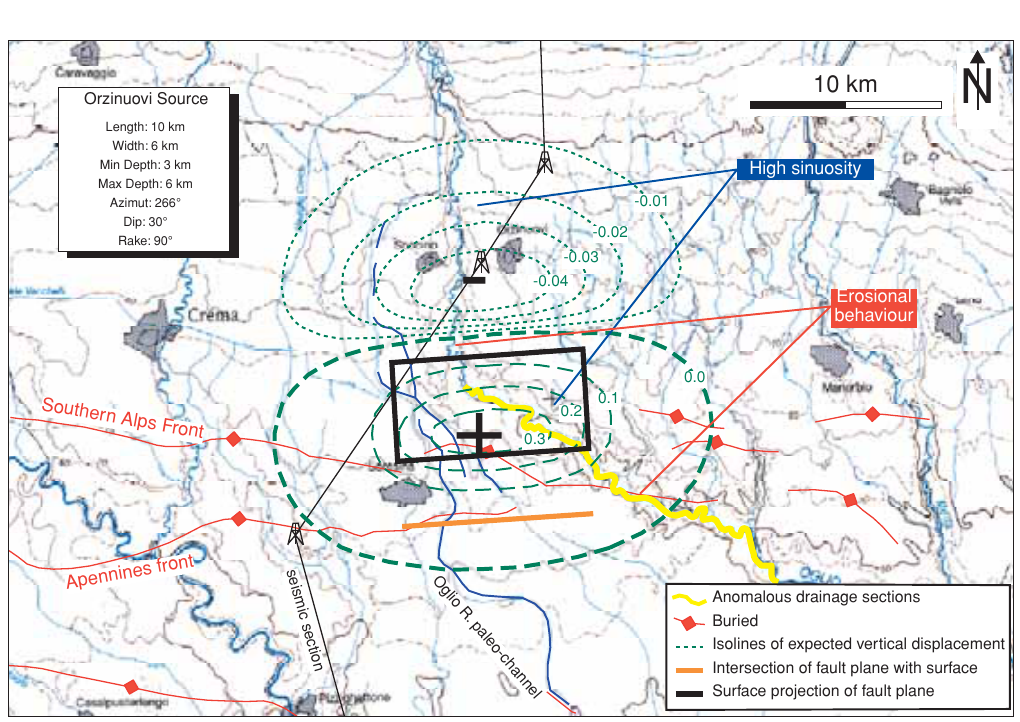
Fig. 8. Summary map showing the position of the proposed causative fault of the 12 May 1802 earthquake, contours of the expected vertical displacement and comparison with the geomorphic observations. Since this is a qualitative test of fault activity, all displacements are referred to unitary slip. Due to the lack of reliable strain and chronological markers, we did not attempt to estimate true cumulative slip and slip rate. The contours express the ratio between slip at depth and surface displacement ( e.g. , for 1 m slip top uplift is 0.3 m). Positions of the buried anticlinal axes and the paleo-channel south of the river diversion are shown. The geometry and location of the modelled fault are constrained using both geomorphological and subsurface geology observa- tions. The abandonment of the paleochannel and the longitudinal anomalies observed along the Oglio River are induced by fault-related tectonic uplift south of the diversion. Topography is from the Map of Relief and Vertical Movements of the Po Plain (MURST,